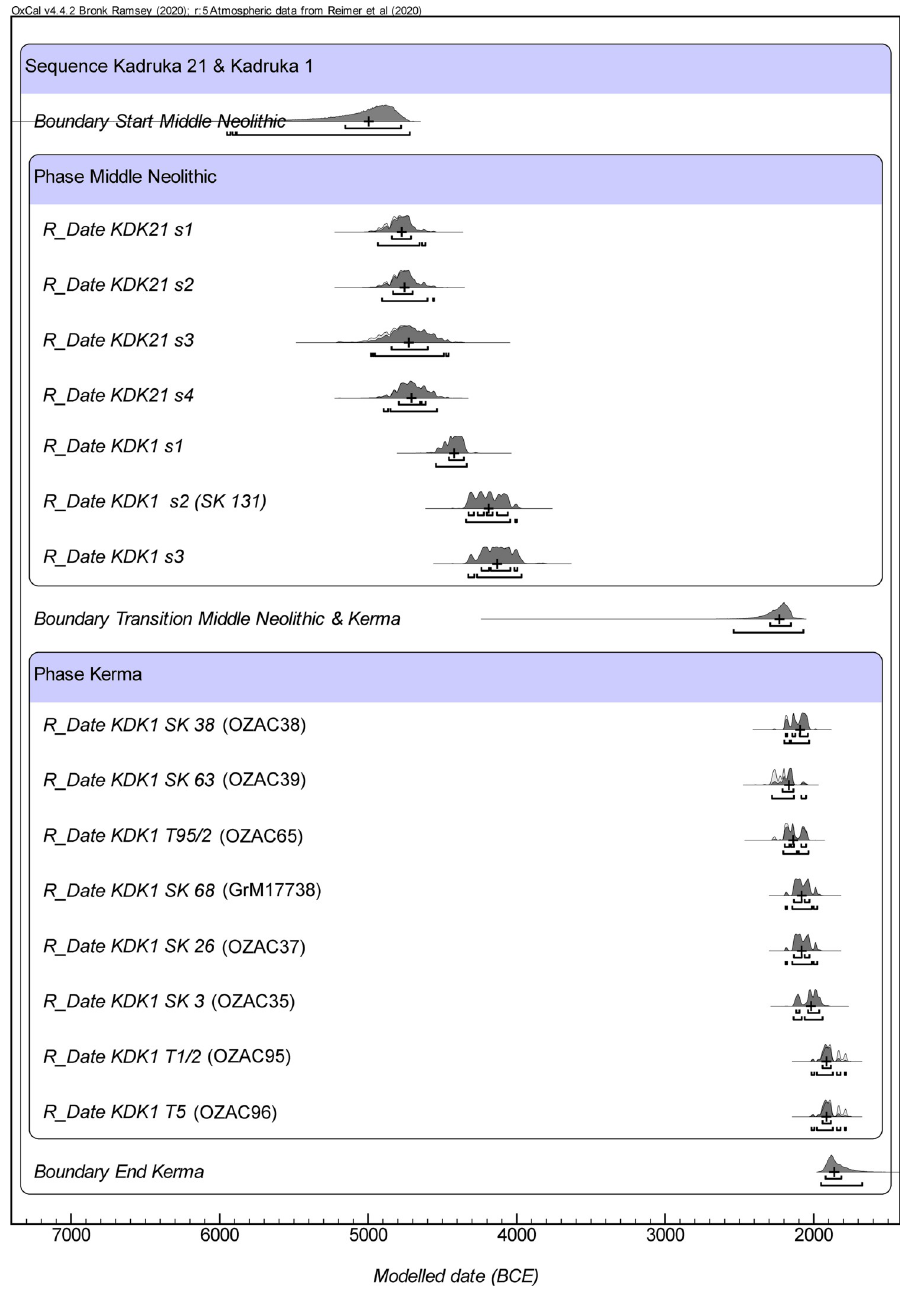
Fig 3. Bayesian model of 14 C dates from KDK21 and KDK1. Prior distributions (unmodelled calibrations) are shown in light grey. Posterior distributions (modelled dates) are shown in dark grey and the plus symbol indicates the median modelled age. The Kerma 14 C date for individual SK 68 was obtained from a hair sample [56]. Middle Neolithic 14 C dates were obtained from Aspatharia spp. bivalves included in grave assemblages [31, 40]. Refer to S5 Table in S1